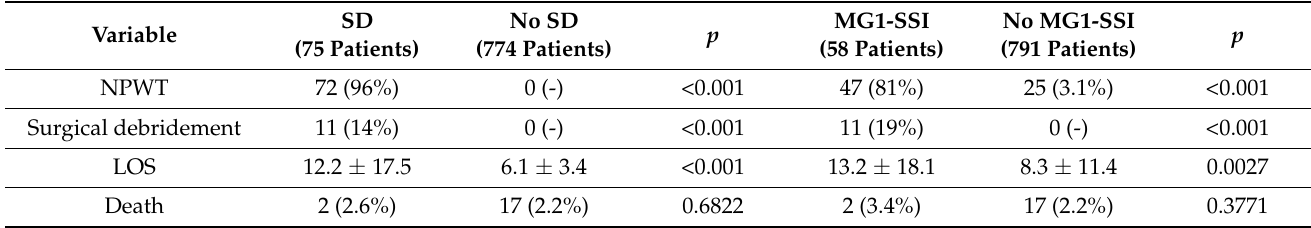
Table 2. Principal outcomes in SD and MG1-SSI groups.